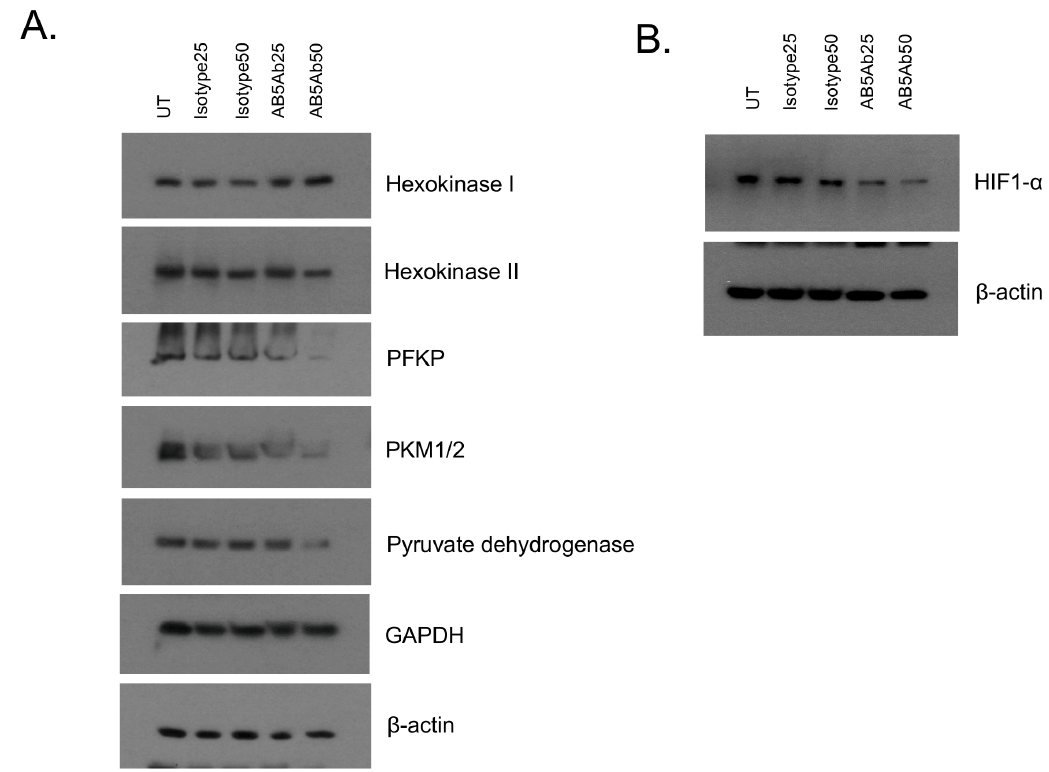
Fig 4. ABCB5 protein blockade inhibits key regulators of the glycolysis pathway. Human wildtype G3361 melanoma cells were treated with different concentrations of blocking anti-ABCB5 mAb clone 3C2-1D12 or corresponding doses of isotype-matched control mAb, or were left untreated for 48 h. Expression of Hexokinase 1, Hexokinase II, PKM1/2, PFKP, Pyruvate Dehydrogenase, GAPDH (A), HIF-1 α (B) and β -Actin was analyzed by Western blot. Data shown are representative of three independent